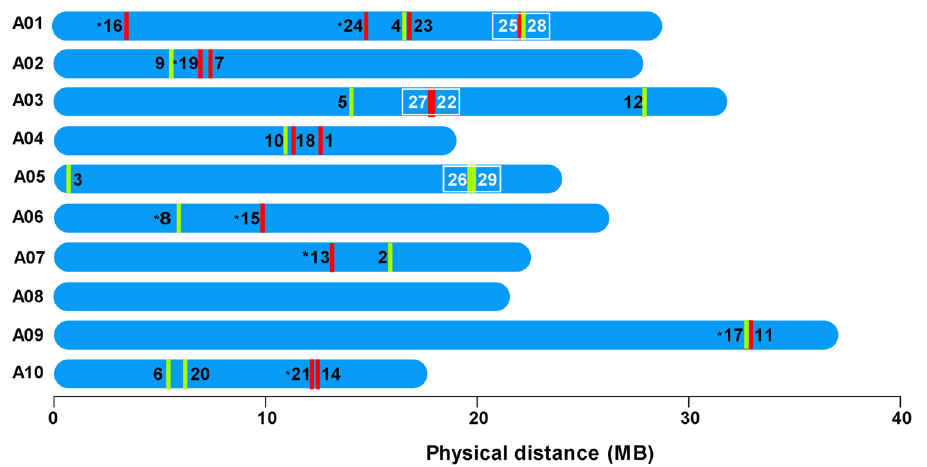
Figure 3. Chromosomal localization and duplication of BrCNGC family genes. Physical location and distance of BrCNGC genes across the 9 chromosomes of B. rapa . BrCNGC genes are shown as numbers on chromosomes, tandemly duplicated gene pairs by white color, while segmental duplications are indicated with asterisks. Red and yellow lines show forward and reverse orientations of each loci